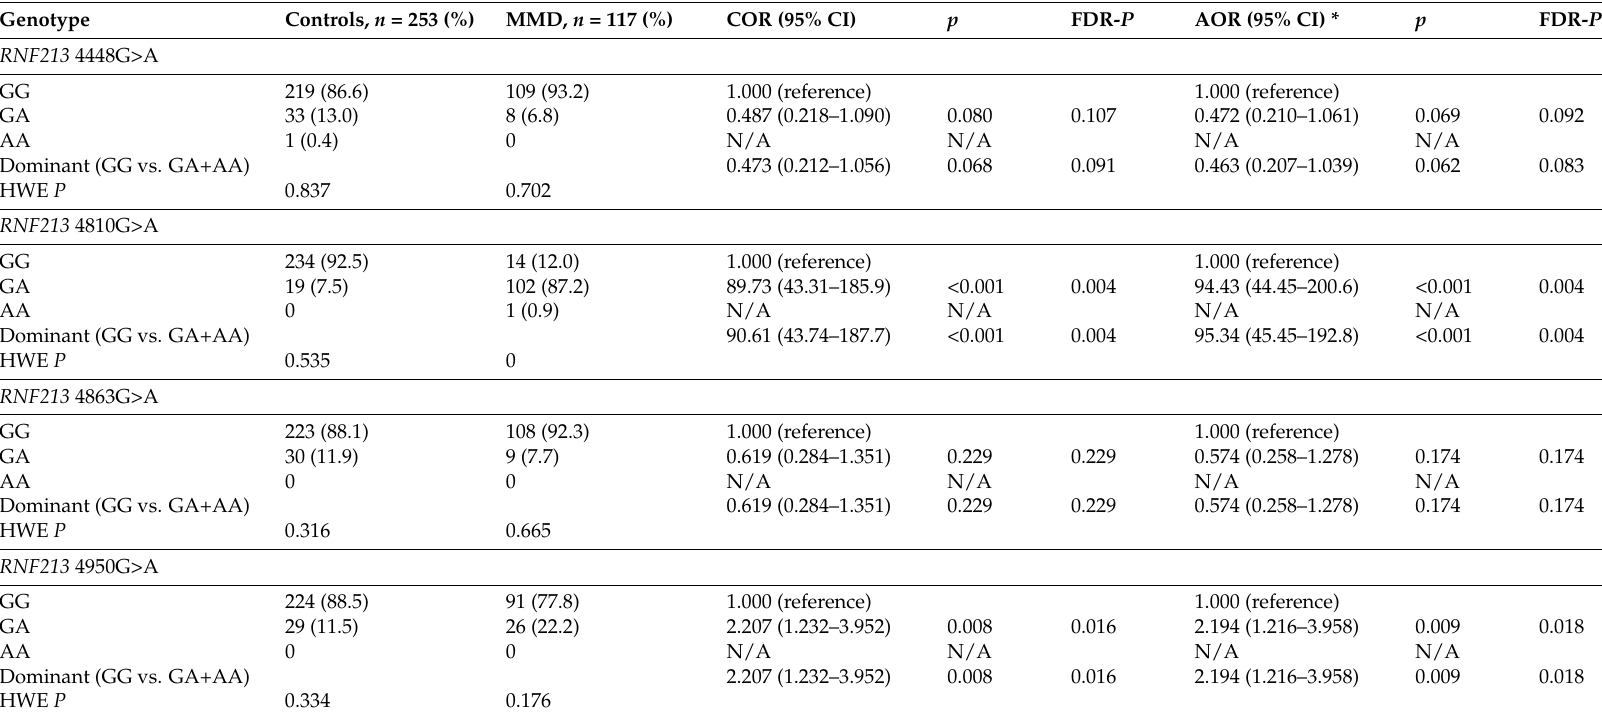
Table 2. Genotype frequencies of RNF213 in moyamoya disease (MMD) patients and control subjects.